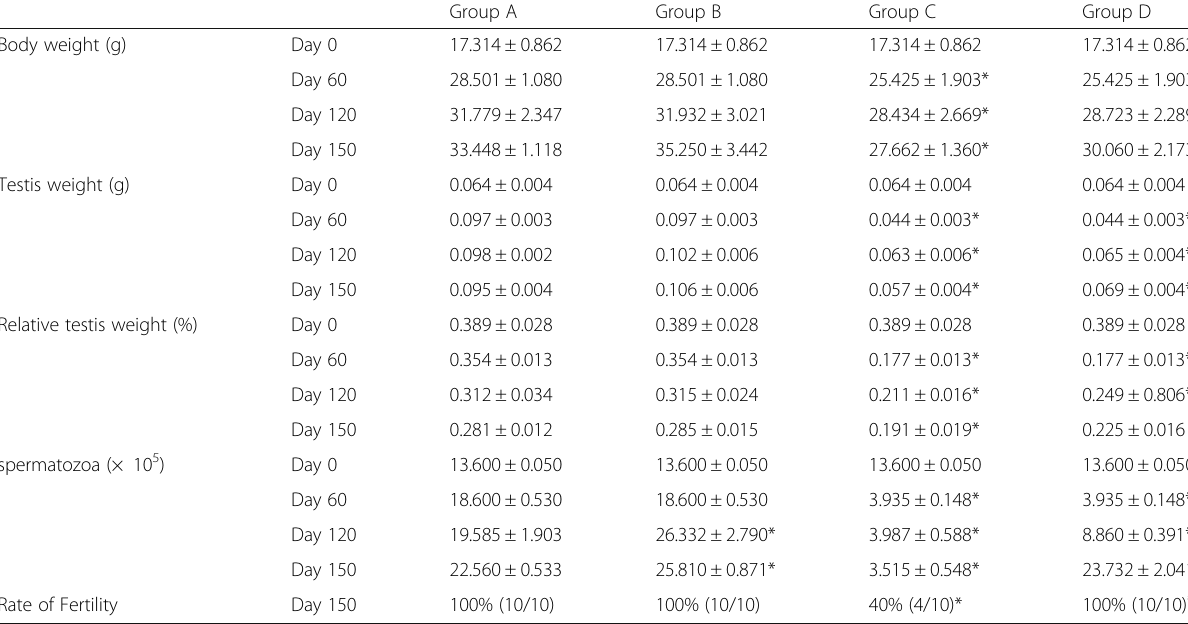
Table 3 Effect of TBI (6Gy) and TJ107 on testicular weight, epididymal spermatozoa, and fertility in male